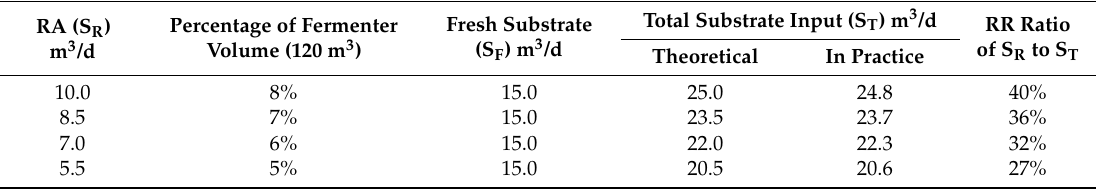
Table 1. Input volumes of fresh substrate (S F ) and recirculated substrate (S R ).